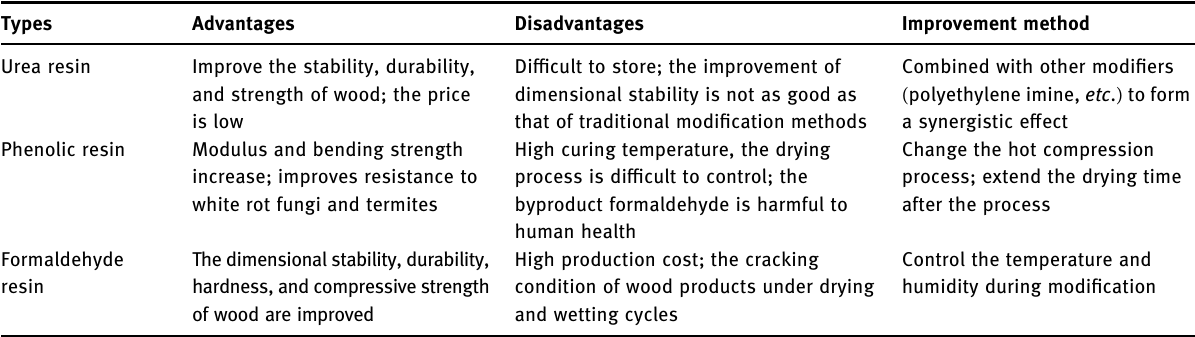
Table 3: Various modi fi cation characteristics of resins